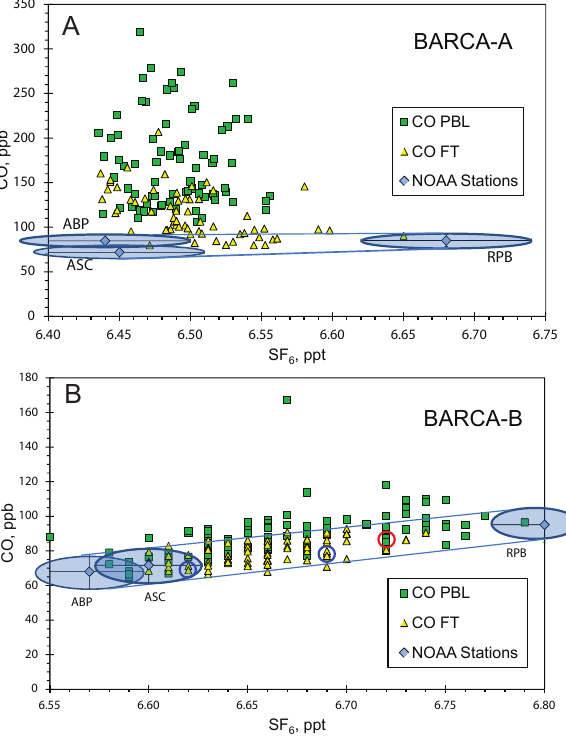
Fig. 4. Plot of CO from the flask samples against sulfur hexaflu- oride (SF 6 ), which serves as a tracer of NH vs. SH airmass origin, for BARCA-A (A) and BARCA-B (B) . The values measured simul- taneously at the NOAA monitoring sites Ragged Point, Barbados (RPB), Arembepe, Brazil (ABP), and Ascension Island (ASC) are shown for reference. The red circle in panel (B) indicates a sam- ple of PBL inflow off the Brazilian coast, the blue circles indicate samples of FT